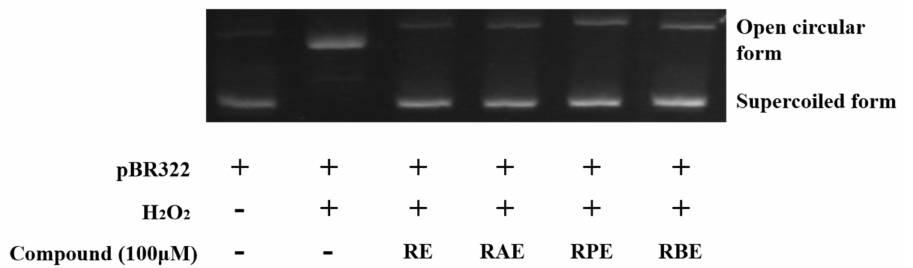
Figure 5. Inhibition of hydroxyl radical-induced DNA scission. Here, RE, RAE, RPE, and RBE denote resveratrol, resveratrol acetate,